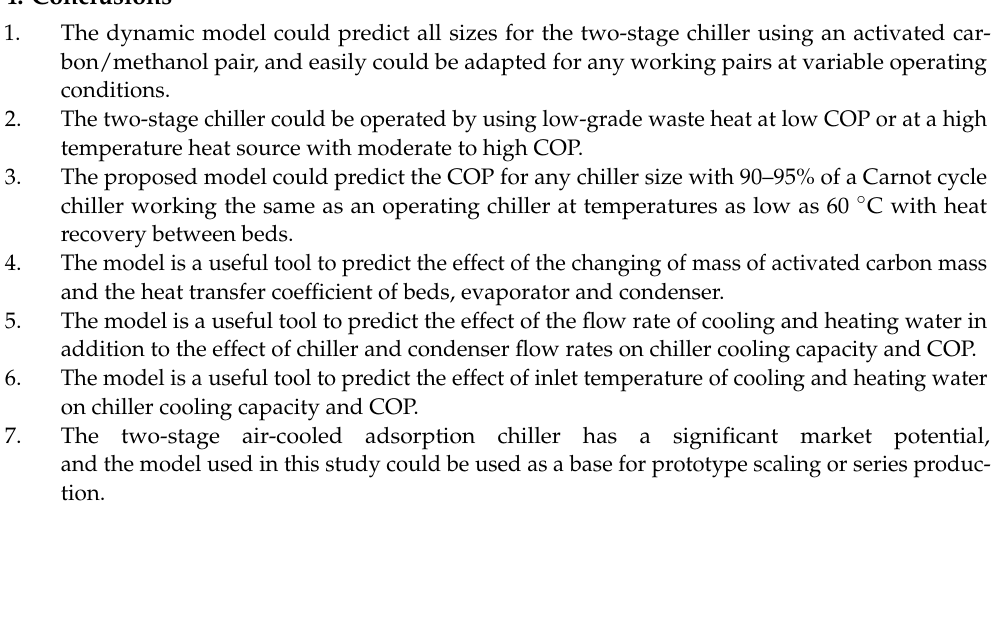
Figure 14. Average cooling capacity for double-sized chiller (results are at chiller nominal operating conditions, shown in Appendix B).